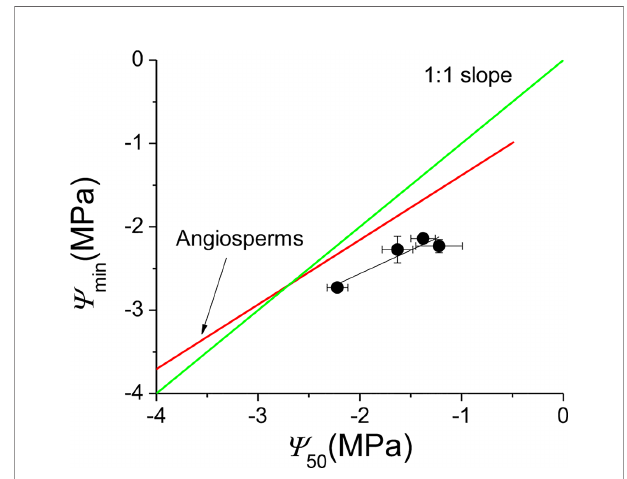
FIGURE 5 | Y min as a function of Y 50 for Populus euphratica at the four sites. The four black points are the means of the four sites. The red line is the regression line fi tted using measurements for angiosperm species in the world (Choat et al., 2012). The F value and probability for the regression black line of Populus euphratica at the four sites are 14.76 and 0.061, respectively. The green line is the 1:1 regression line between Y min and Y 50 . Errors bars represent ±